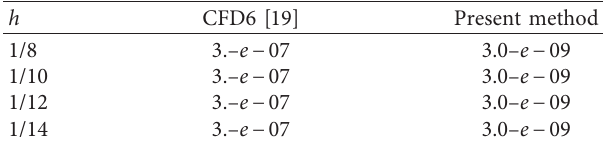
Table 2: Comparison of convergence rates for t � 0 . 001 for Test Problem